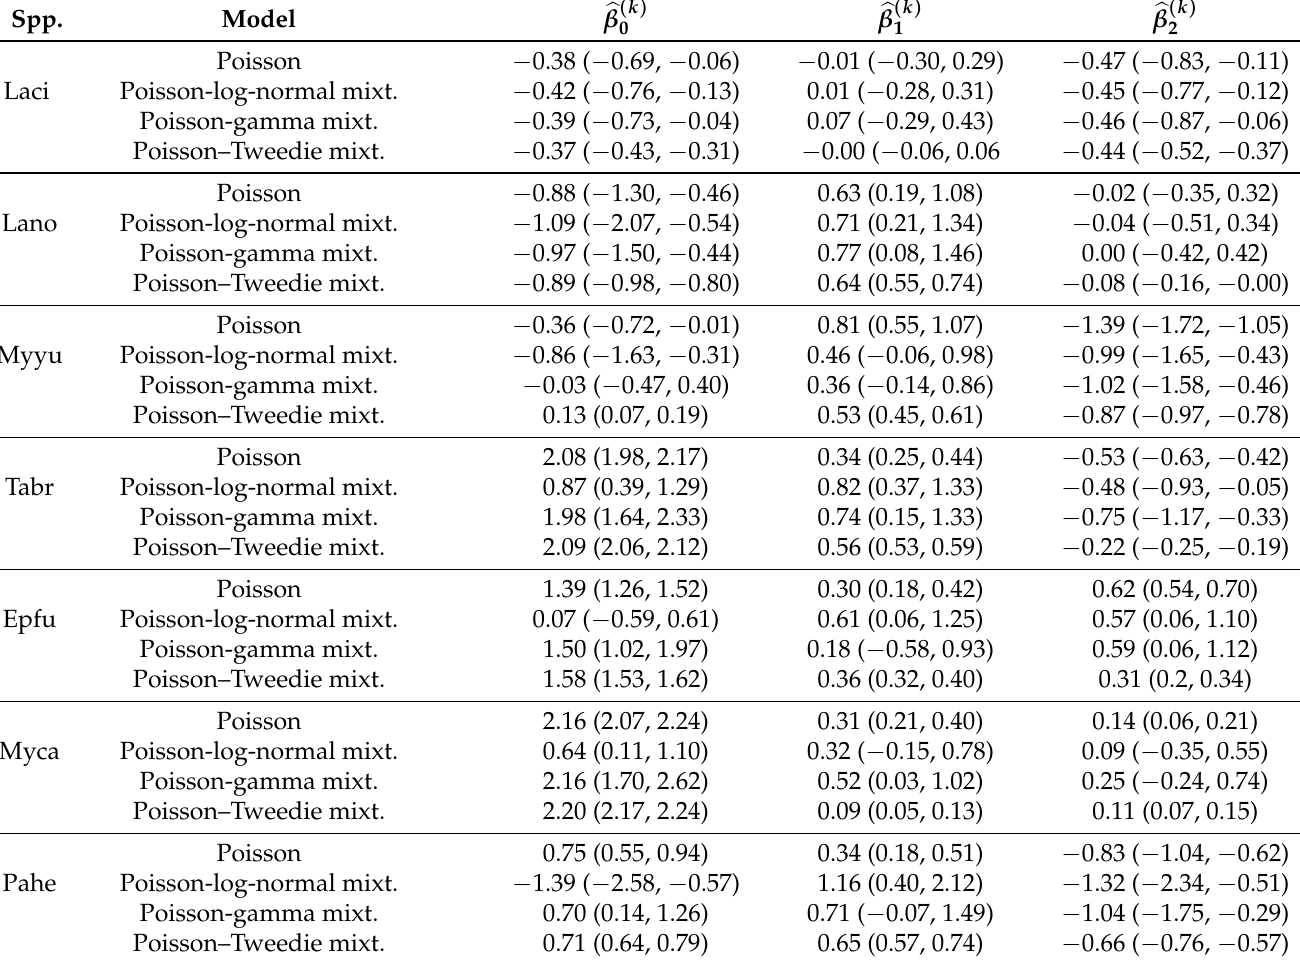
Table 1. Parameter estimates with either 95% confidence or credible intervals when fitting a Poisson GLM, a Poisson-log-normal mixture model, a Poisson-gamma mixture model, and a Poisson–Tweedie mixture model to each species (spp.) in the bat acoustic count data. Seven bat species were recorded in oak woodlands of California, labelled by the following abbreviations: Tadarida brasiliensis (Tabr), Eptesicus fuscus (Epfu), Lasionycteris noctivagans (Lano), Lasiurus cinereus (Laci), Parastrellus